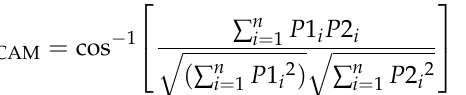
Figure 8. Frequency distribution map generated from light detection and ranging (LiDAR) data of a forest stand. ( a ) A forest stand and the LiDAR data. ( b ) The profile curve of the forest stand.